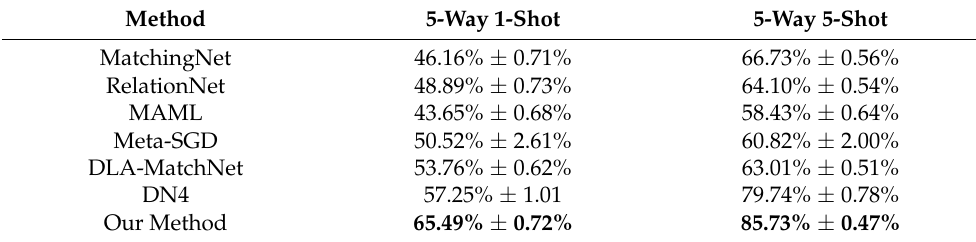
Table 3. Experimental results of different methods on the UC Merced dataset.